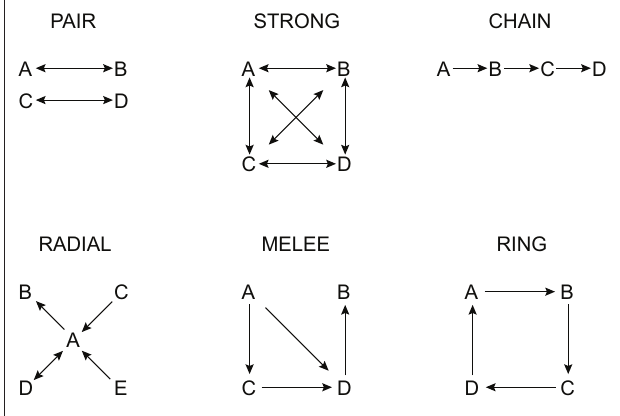
FigurE 1 | Configuration types manipulated in the reciprocals video